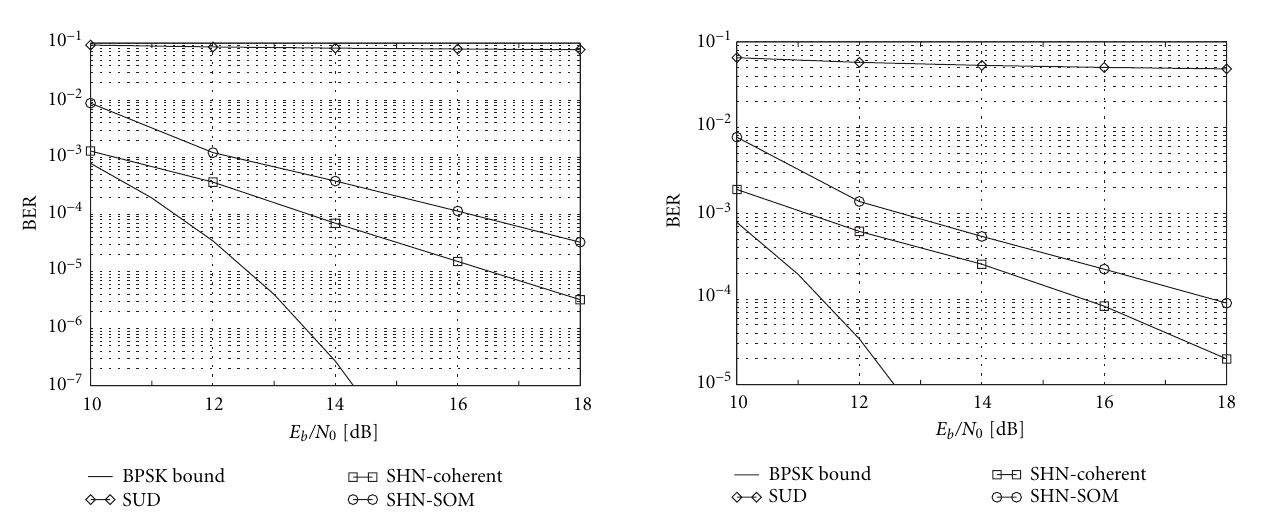
Figure 10: The OPOBS channel with extended Gold codes.